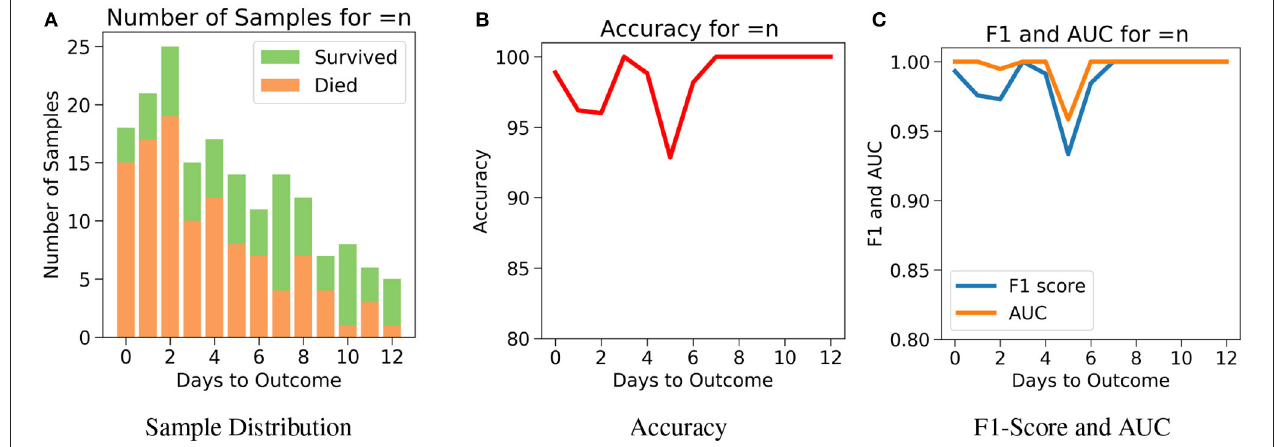
FIGURE 7 | The performance of neural net on the test data using case 3: Number of days to outcome equal to n . (A) The class-wise distribution of the cumulated data-points ( ≤ nth day) for all samples in the imputed test set. (B) Accuracy of the model evaluated for different days to outcome. (C) F1-score and AUC of the model evaluated for different days to